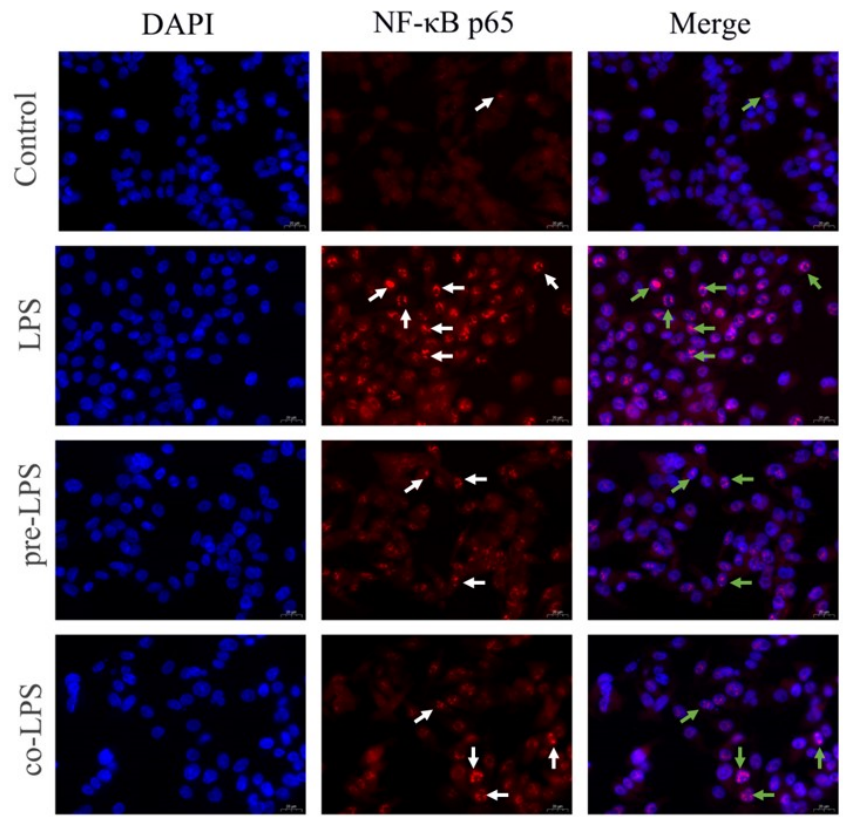
Figure 7. Reuterin inhibited LPS-stimulated NF- κ B p65 subunit nuclear translocation in HD11 macrophages. The nuclei were DAPI-stained (blue), and the p65 of treated cells was visualized through immunofluorescence staining with anti-p65(red) antibody. Scale bar = 20 µ m. The red area (representative of the area that contained p65) and blue area (representative of the nucleus part that is DAPI conjugated) images were overlaid to create a purple fluorescence in areas of colocalization. White arrows exhibited the p65 immunolabeling in HD11 cells; green arrows indicated the colocalization of p65 immunolabeling within the nucleus.